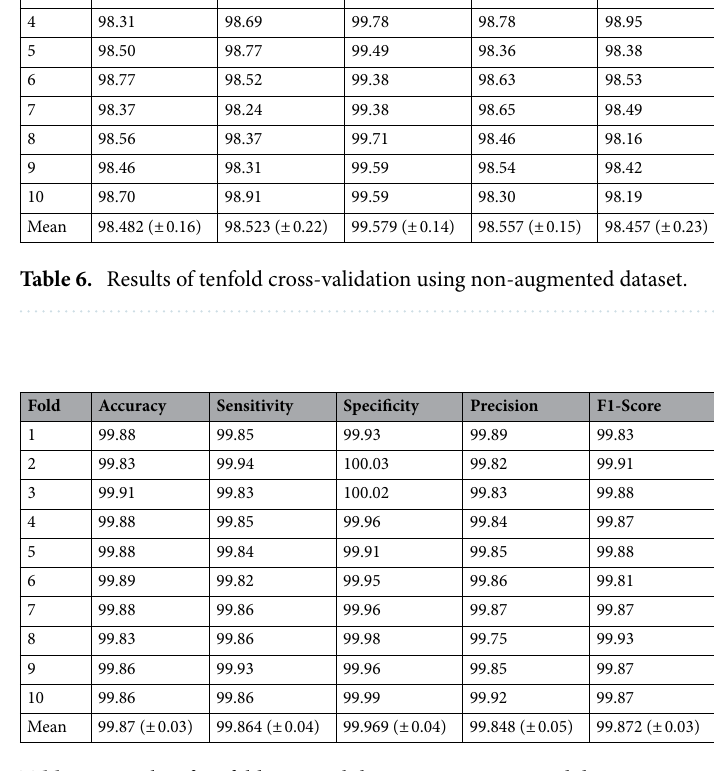
Table 7. Results of tenfold cross-validation using augmented dataset.